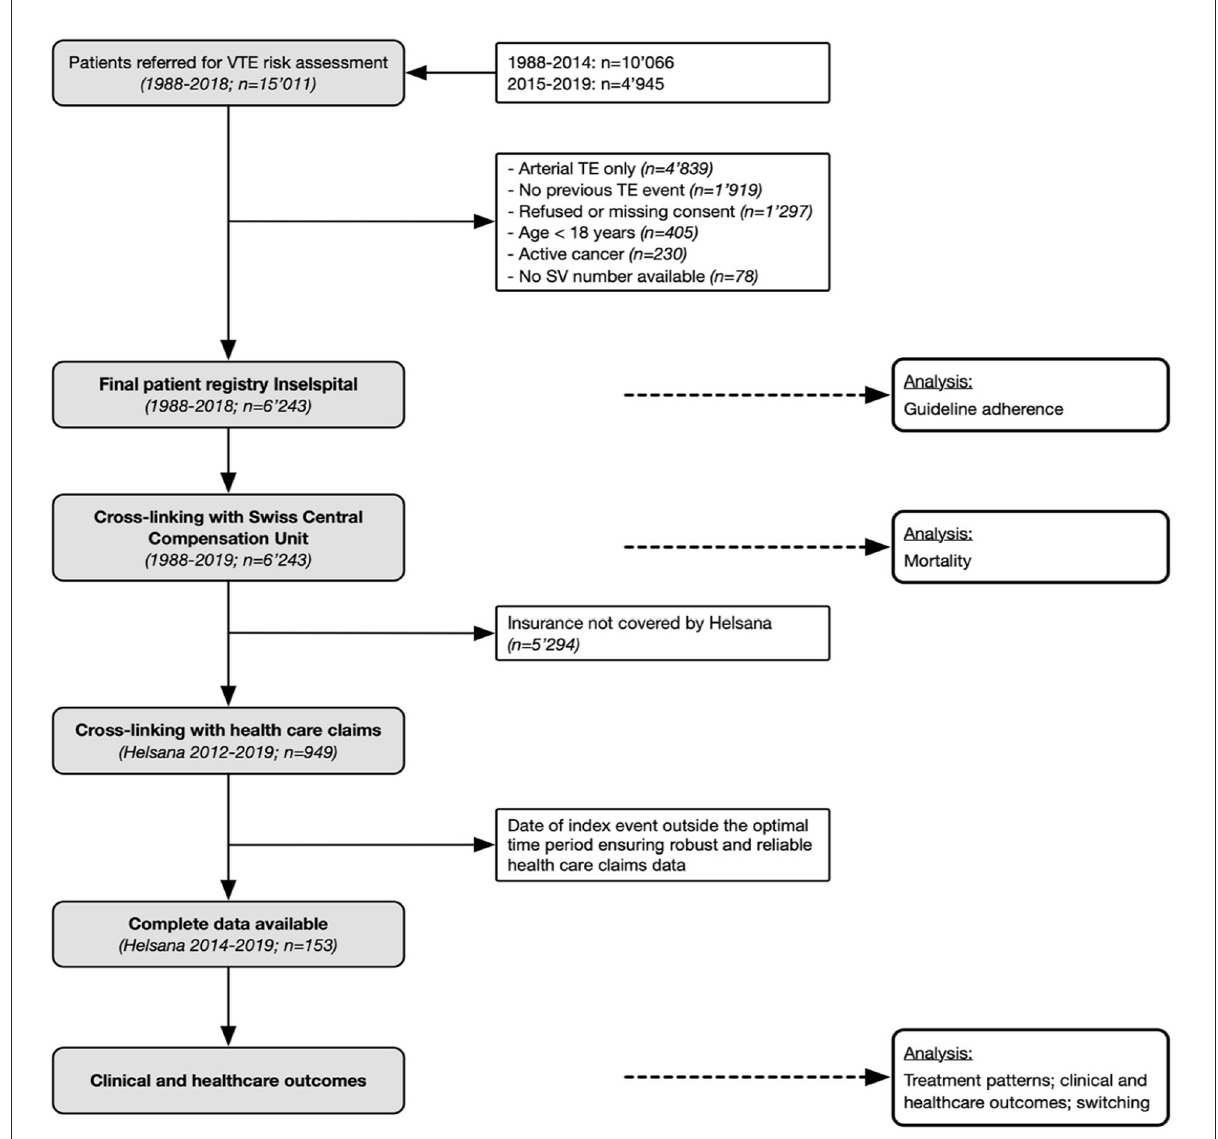
FIGURE1 Flow of the patients. In a long-term prospective cohort study including patients with VTE, the adherence of treatment recommendations with evidence-based guidelines were studied, predictors established, treatment patterns observed, and various outcomes studied.